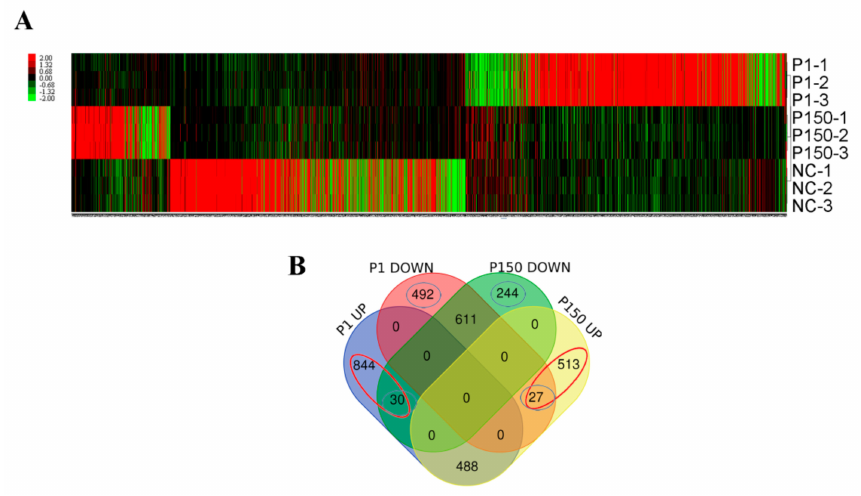
Figure 3. Profile of di ff erentially expressed genes (DEGs) in the three groups. ( A ) Hierarchical heat map showing the expression dynamics of DEGs. P1-1 to 3 represent the calves of P1 group; P150-1 to 3, the calves of P150 group; NC-1 to 3, the calves of mock-infected group; ( B ) Venn diagrams of DEGs in peripheral blood mononuclear cells isolated from the calves of P1 and P150 groups versus mock-infected group. The red circle with “844” and “30” and the blue circles with “492” and “27” represent up- and down-regulated DEGs in P1 group after excluding common genes with similar trends of P150 group, respectively. Similarly, the red circle with “513” and “27” and the blue circles with ”44” and “30” represent up- and down-regulated DEGs in the P150 group after excluding common genes with similar trends of P1 group,